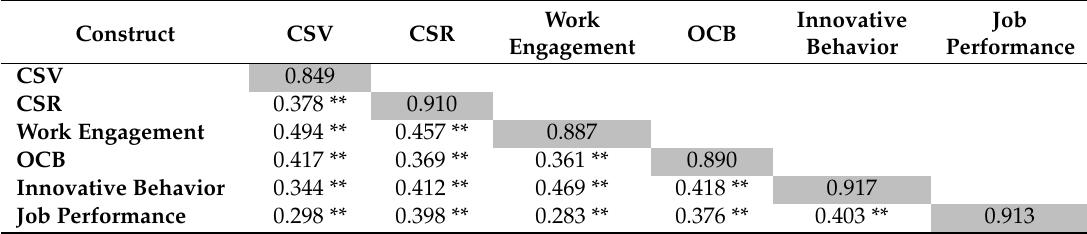
Table 5. Results of discriminant validity.